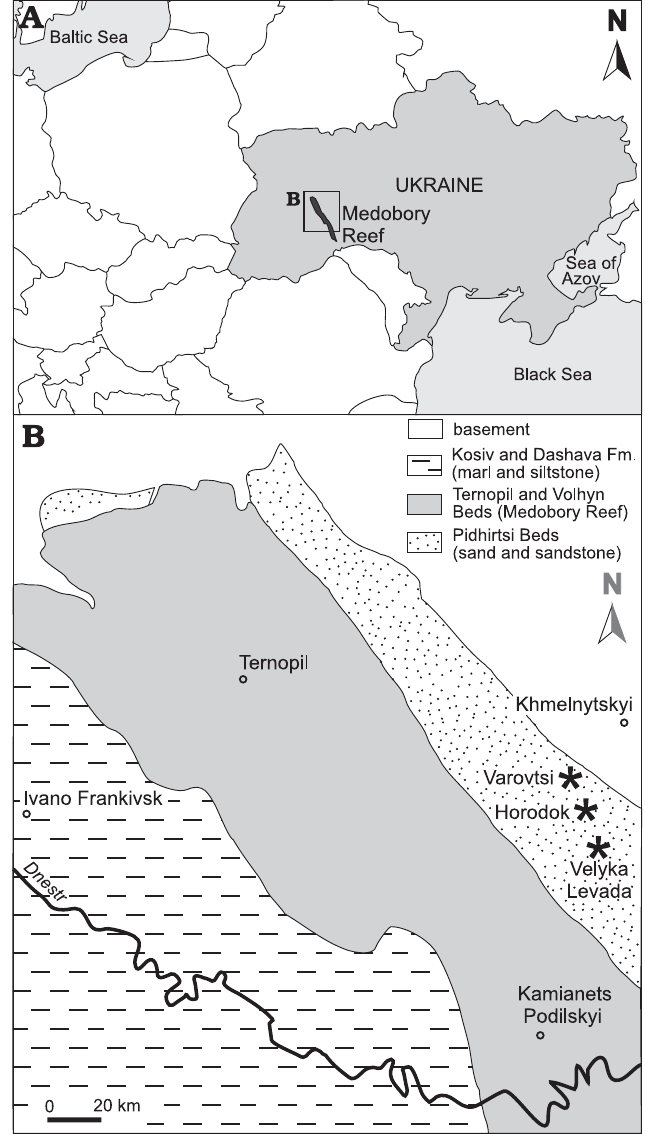
Fig. 1. A . Schematic map of Ukraine and the location of the study area. B . Distribution of the principal lithostratigraphic units in the area of study and location of the three sampled sites